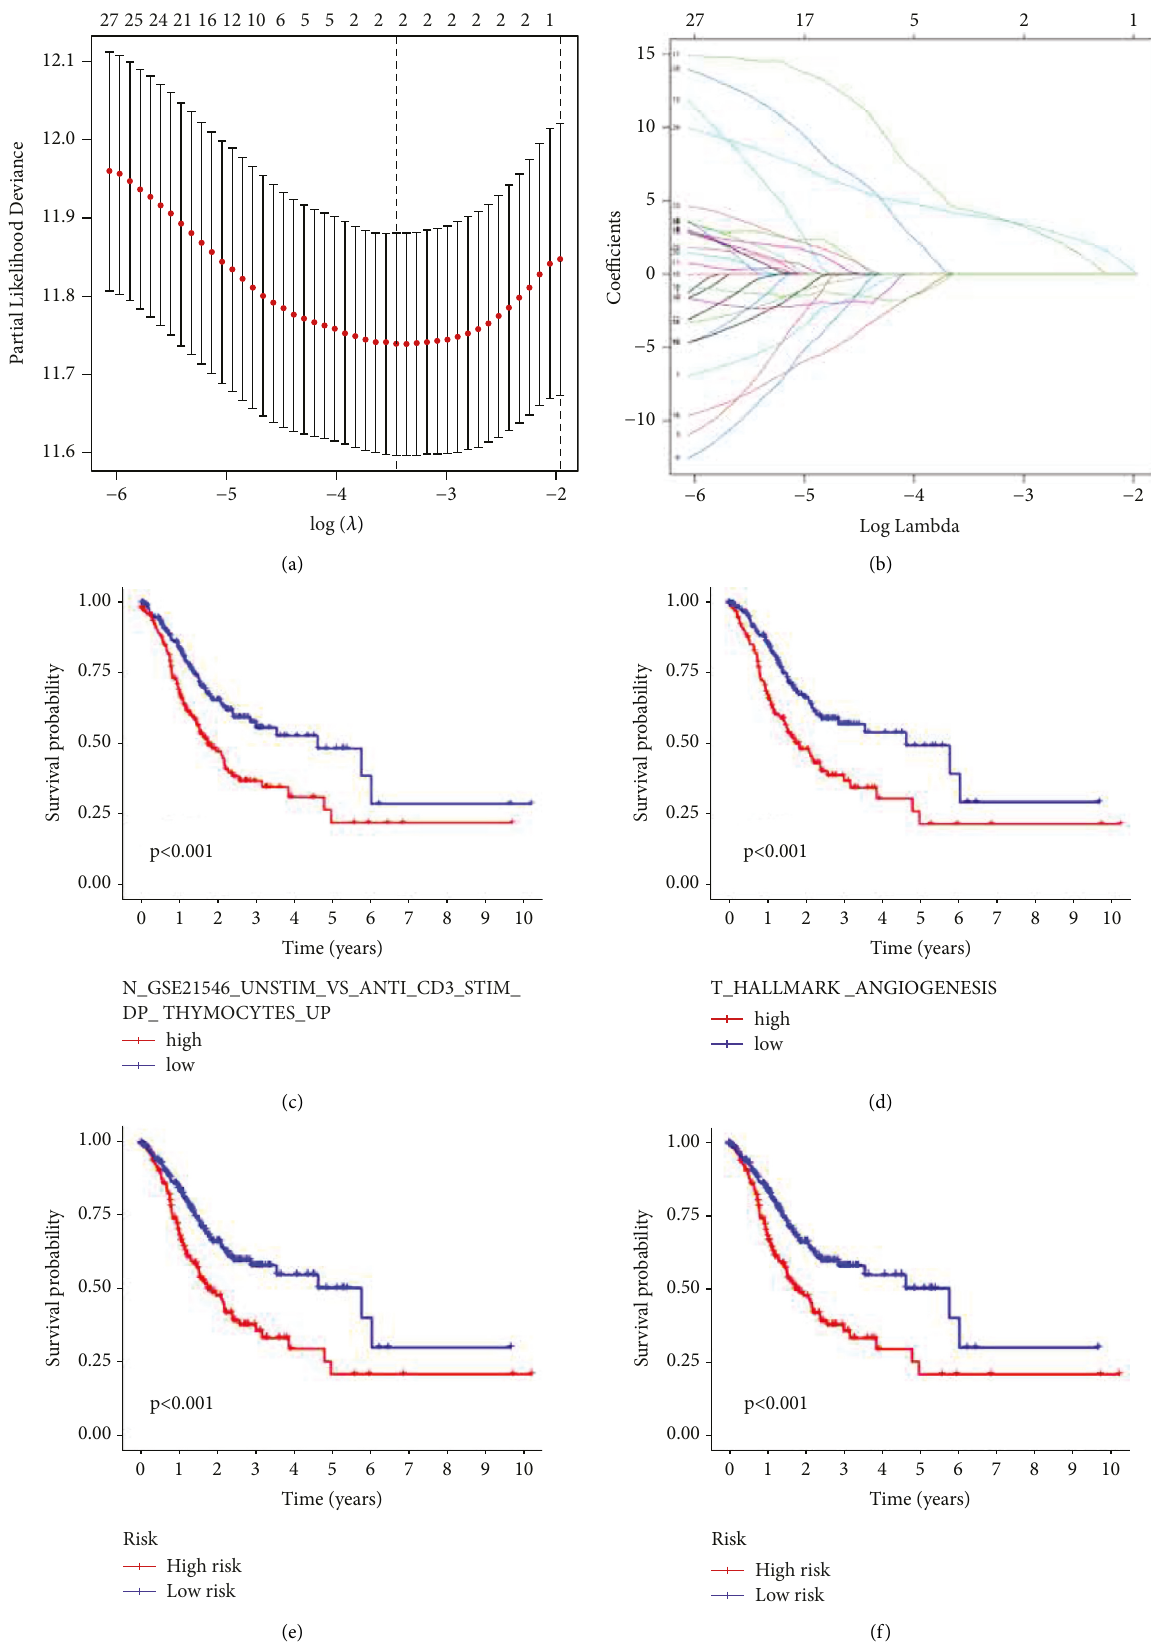
Figure 5: Identification of prognostic gene sets by Lasso regression model. (a) Optimal values of λ were shown. (b) Coefficient profiles of core gene sets were calculated. (c) Survival analysis of gene sets in normal tissues. (d) Survival analysis of gene sets in tumor tissues. (e) Prognostic value of LASSO regression risk model based on gene sets in TCGA cohort. (f) Validation of prognostic of risk model in GEO